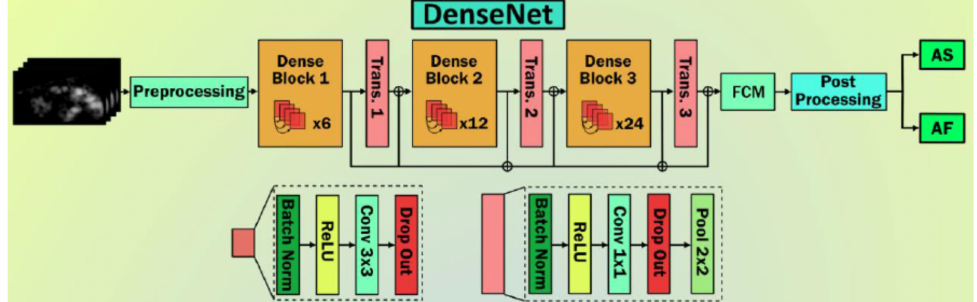
Figure A2. The general structure of Densenet architecture (courtesy of AtheroPoint™, Roseville, CA, USA) [292].